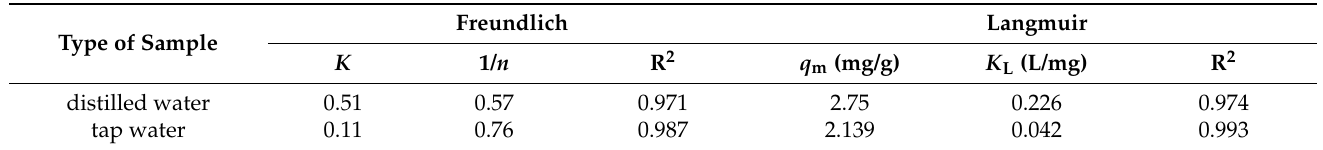
Figure 6. Freundlich linearised isotherm for the removal of ammonium ions from NH 4 Cl solution in tap water. Table 3. Langmuir and Freundlich model parameters.